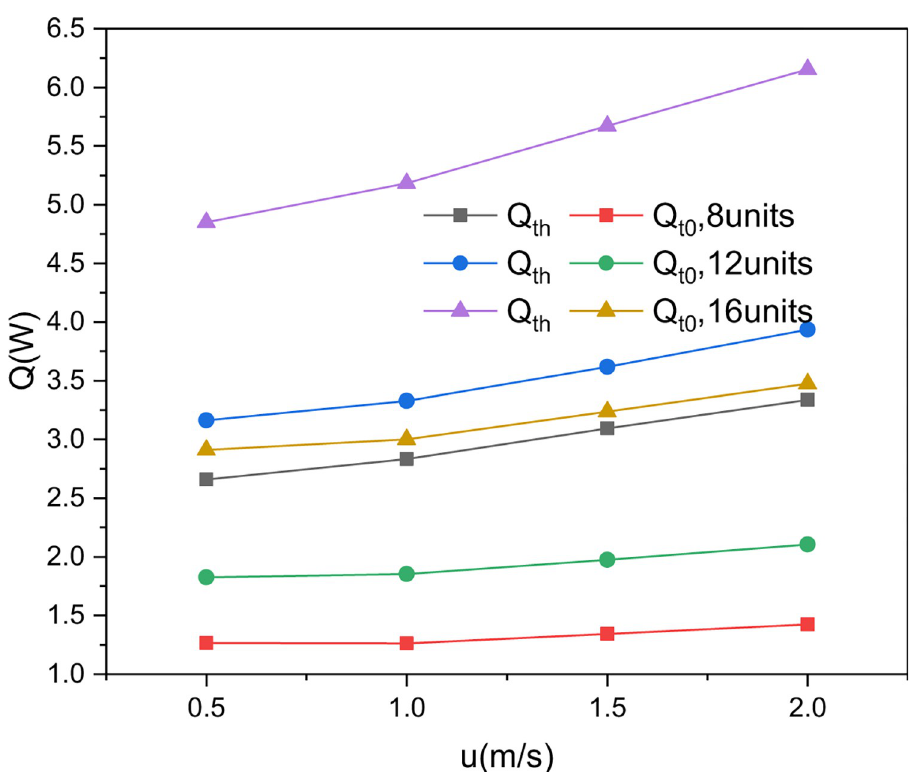
Fig 18. Simulated heating and cooling capacities of the continuous torsional refrigeration module as functions of the air velocity and alloy–stepping motor units.